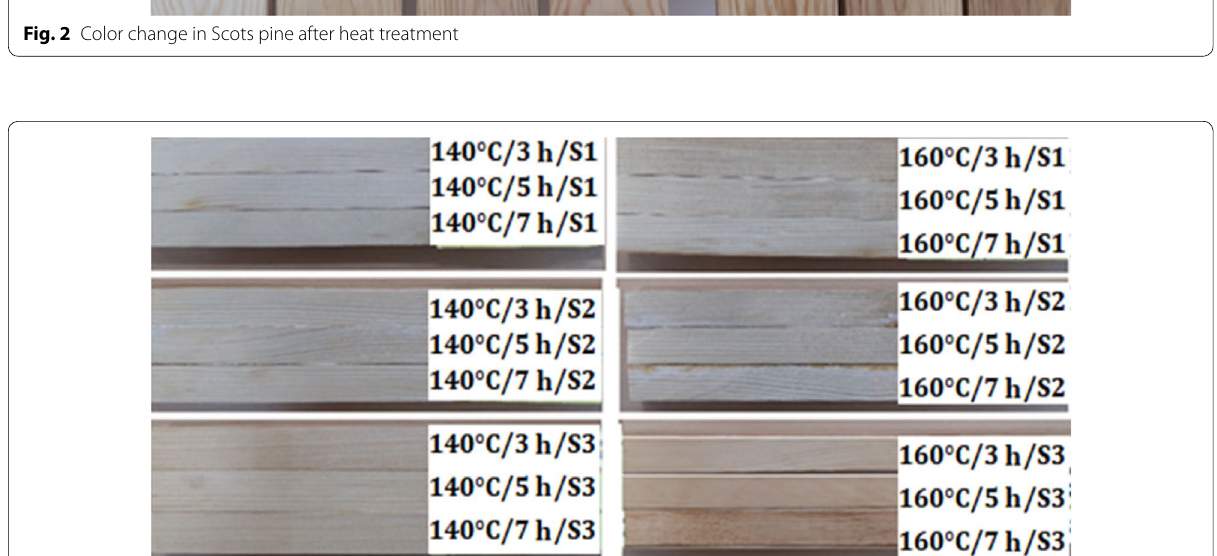
Fig. 3 Heat-treated Scots pine samples after bleaching